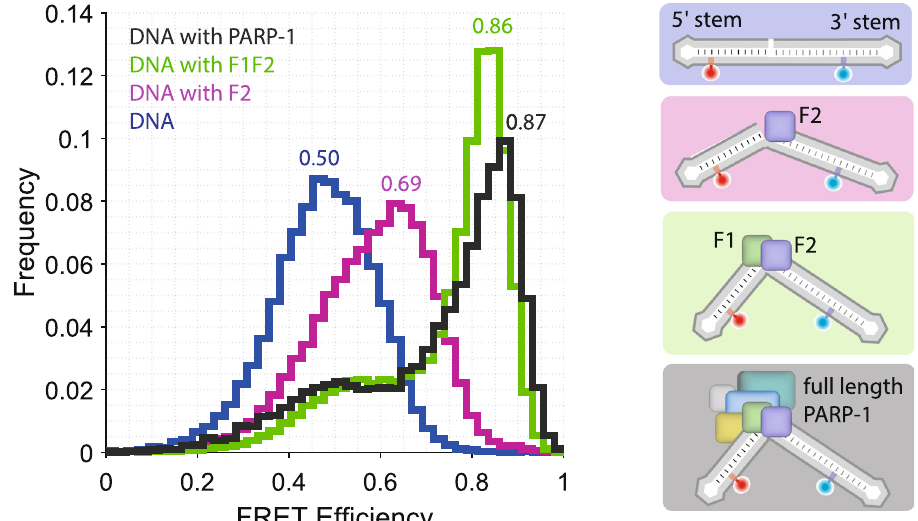
Fig.2|DNAconformationduringnickrecognitionprobedbysmFRET. smFRET ef fi ciencyhistogramofnickedDNA(blue)andnickedDNAinthepresenceofeither F2 (magenta), F1F2 (green) or full-length PARP-1 (grey here, the same histogram as